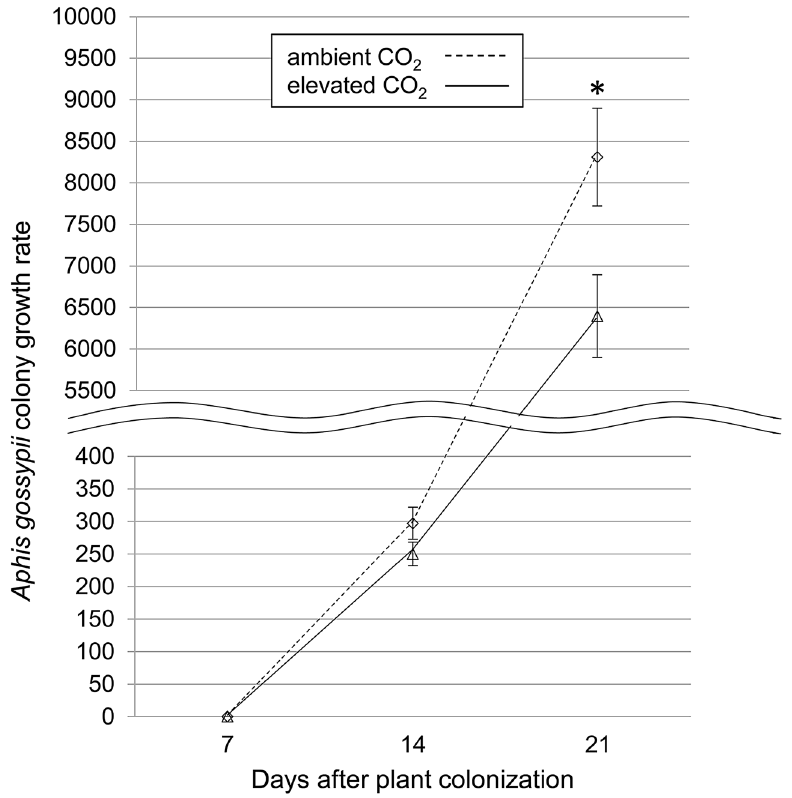
Figure 6. Colony growth rate of Aphis gossypii . The mean (± SE) of the colony growth rate was measured as the sum of nymphs and adults of Aphis gossypii developed under ambient (400 ppm) or elevated CO 2 (700 ppm). Each colony was generated from two adult females reared on melon plants acclimated for two weeks to the respective CO 2 concentration. Growth rates were calculated weekly (day 14 as the difference in the number of aphids on day 14 compared to day 7; and day 21, comparing the number of aphids on day 21 to day 14). Ten (n) A. gossypii colonies per CO 2 concentration. P-values based on Student t -test (*P ≤